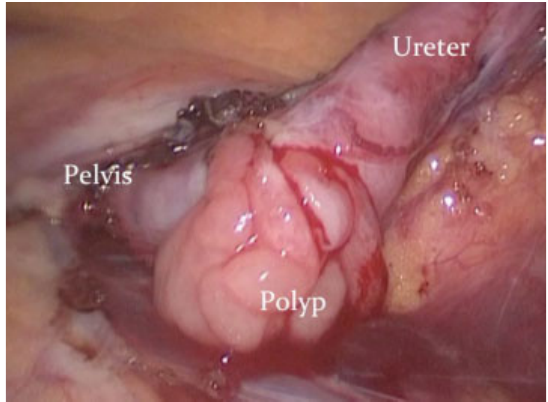
Fig. 4 Ureteral polyp protruding outside from the incision of UPJ. UPJ, ureteropelvic junction.